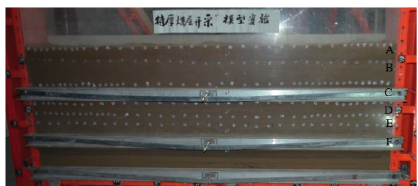
Figure 7: Experimental model and measuring point